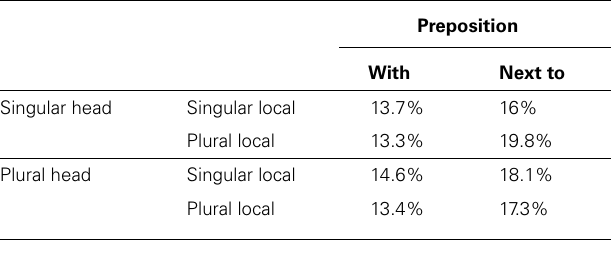
Table 2 | Percentage of miscellaneous errors per condition.